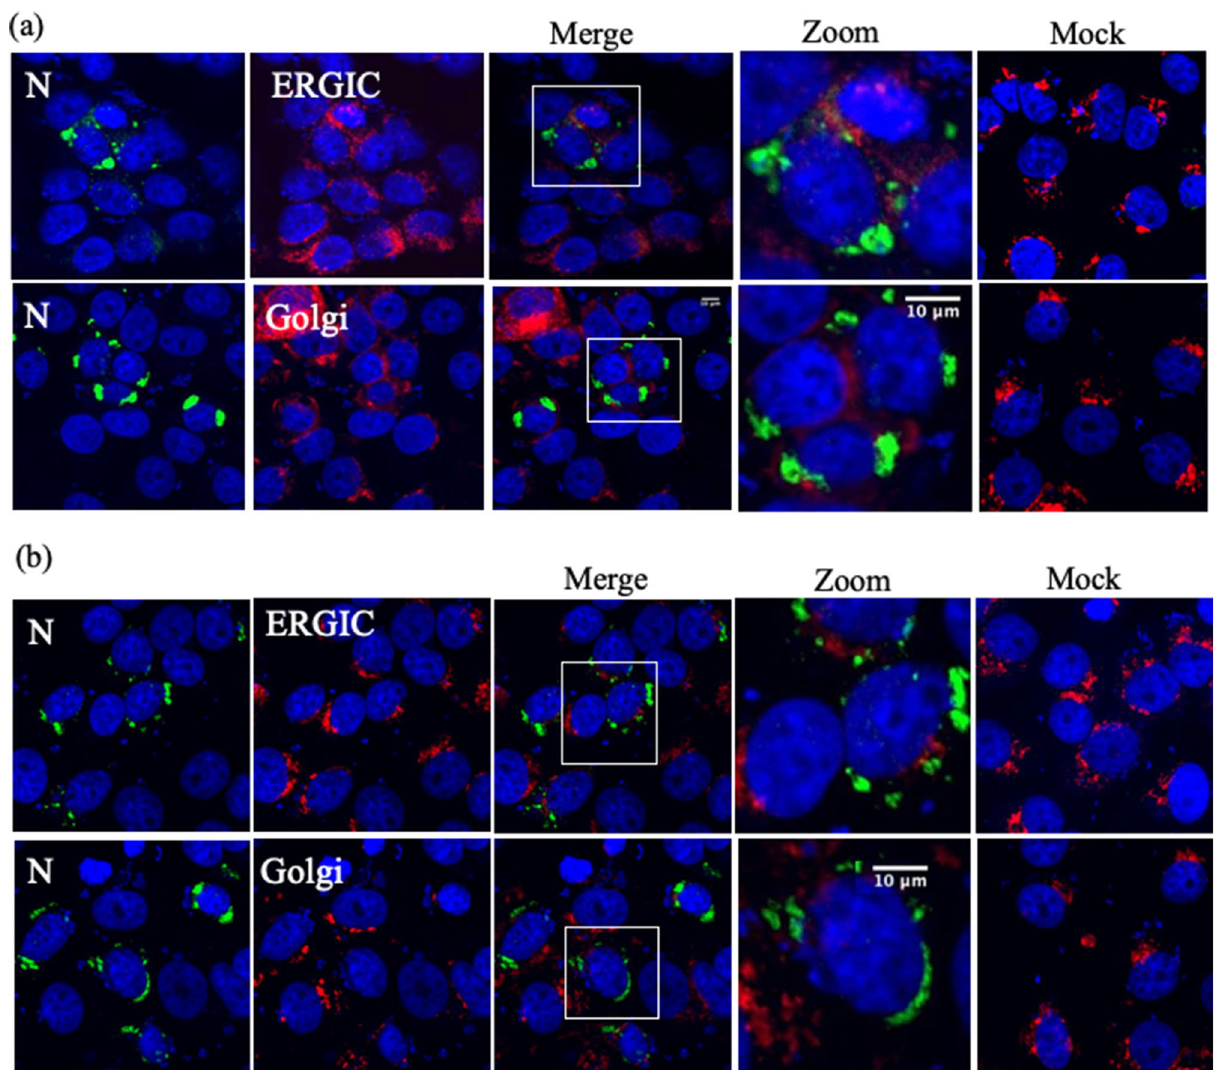
Figure 1. Subcellular localization of N proteins with GP or RdRp. (a) Effect of GP and RdRp expression on the localization of N in Vero E6 cells. Vero E6 cells were transfected with pCAGGS-SFTSV-N, pCAGGS-SFTSV-GP, and pCAGGS-SFTSV-RdRp and subsequently fixed at 24 h post-transfection (hpt). (b) Effect of RdRp and vRNA-Rluc on the localization of N in Vero E6 cells. Vero E6 cells were transfected with pCAGGS-SFTSV-N, pCAGGS-SFTSV-RdRp, and vRNA-Rluc and subsequently fixed at 24 hpt. The cells were stained with antibodies against N protein (green) and ERGIC or Golgi organelle markers (red), and the nuclei were stained with DAPI (blue). Magnification of the merged area is shown on the right side of the merged image. The mock-transfected cells are shown as mock